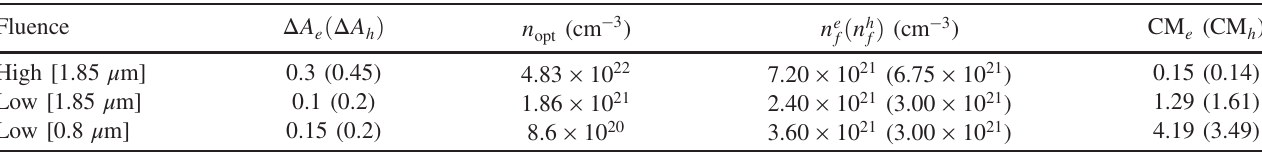
TABLE I. Carrier multiplication factor.